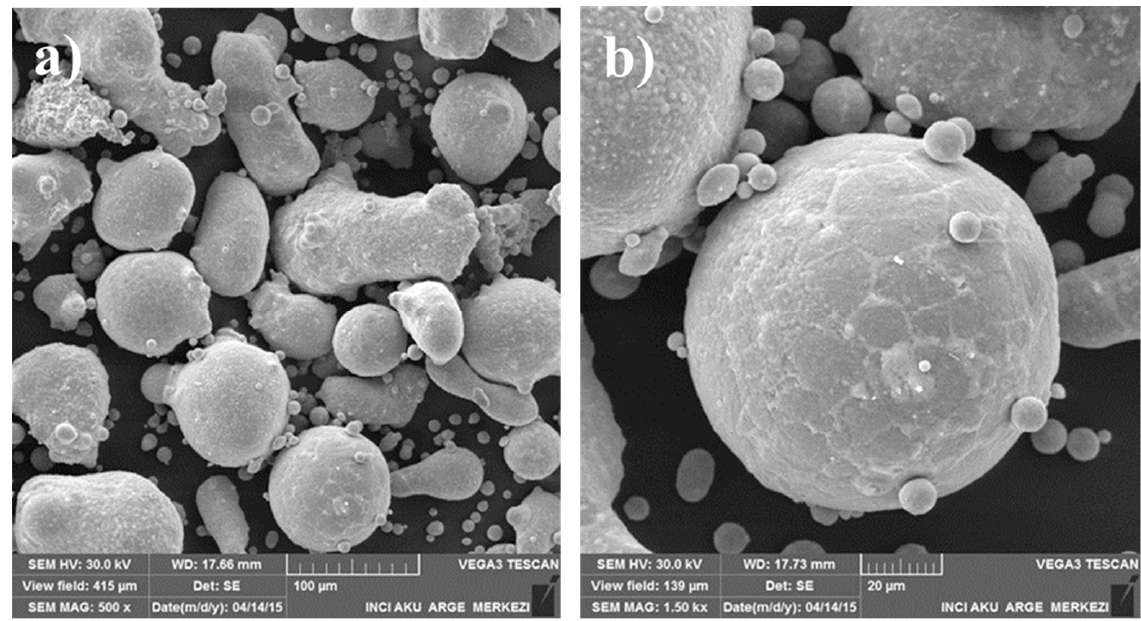
Figure 3. SEM micrographs showing Cu-10Sn powder shape after gas atomization process ( a ) with low and ( b ) high